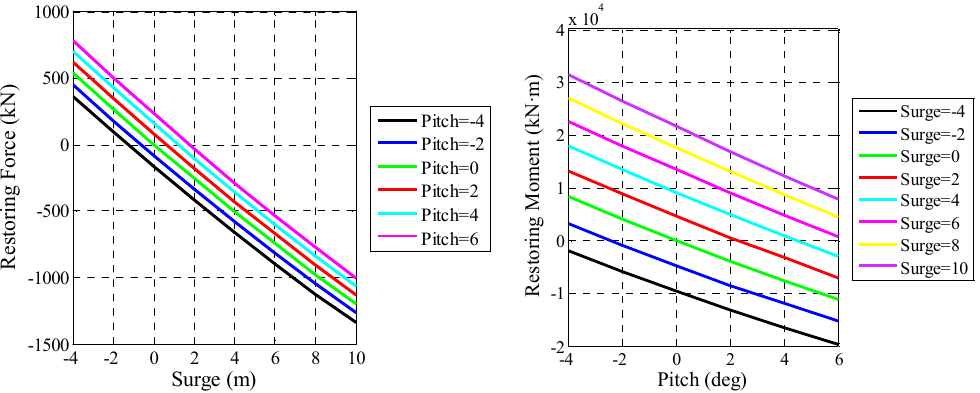
Figure 10. Load-displacement relationships for the horizontal spring mooring system (under 0° load direction).